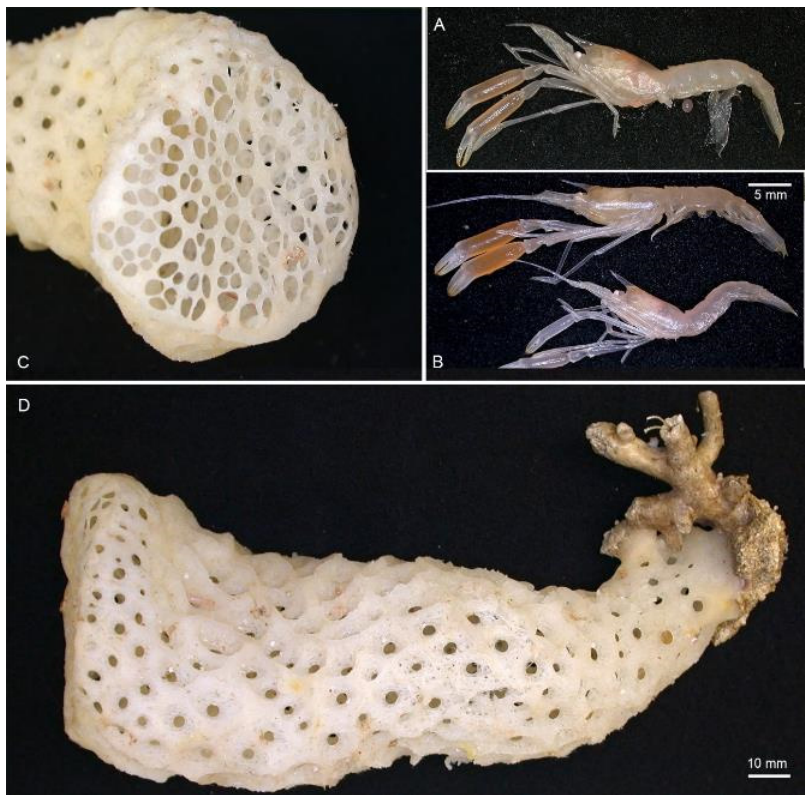
Figure 22. Live coloration of Spongiocaris antipodes sp. nov and euplectellid sponge host Regadrella okinoseana Ijima, 1896 [46] (Hexactinellida, Lyssacinosida, Euplectellidae) specimen collected on southern Norfolk Ridge during 2003 NORFANZ expedition: ( A ) NMNZ CR.019259, ( B – D ) NMNZ CR.019494, scale applies to both A and B.